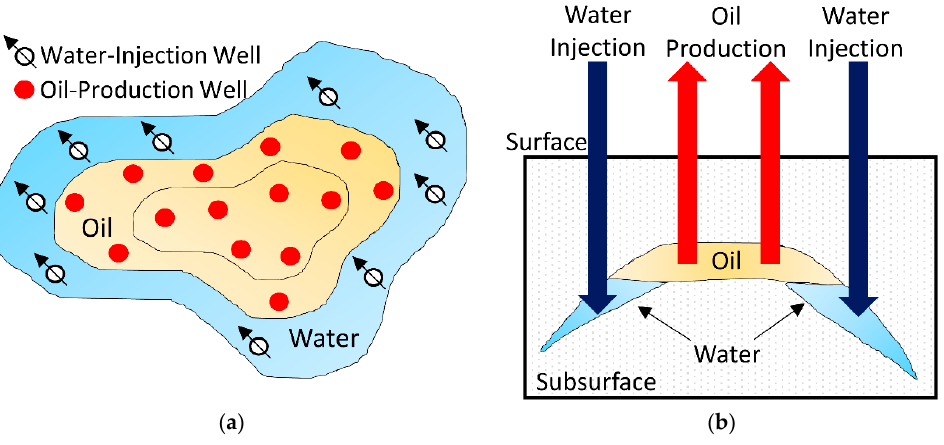
Figure 1. A common scheme for injection of water in oil fields. ( a ) Top view of an oil field composed of water-injection and oil-production wells; ( b ) The water flooding process. The injected water moves the oil up, increasing the oil production.